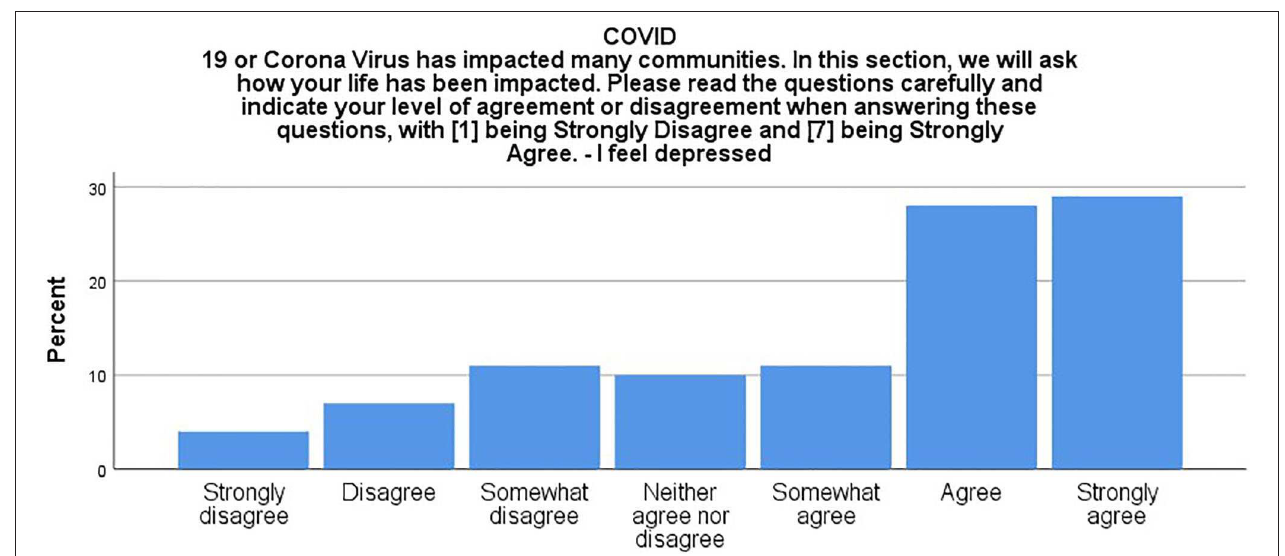
FIGURE 11 | Distribution of participants reporting feeling